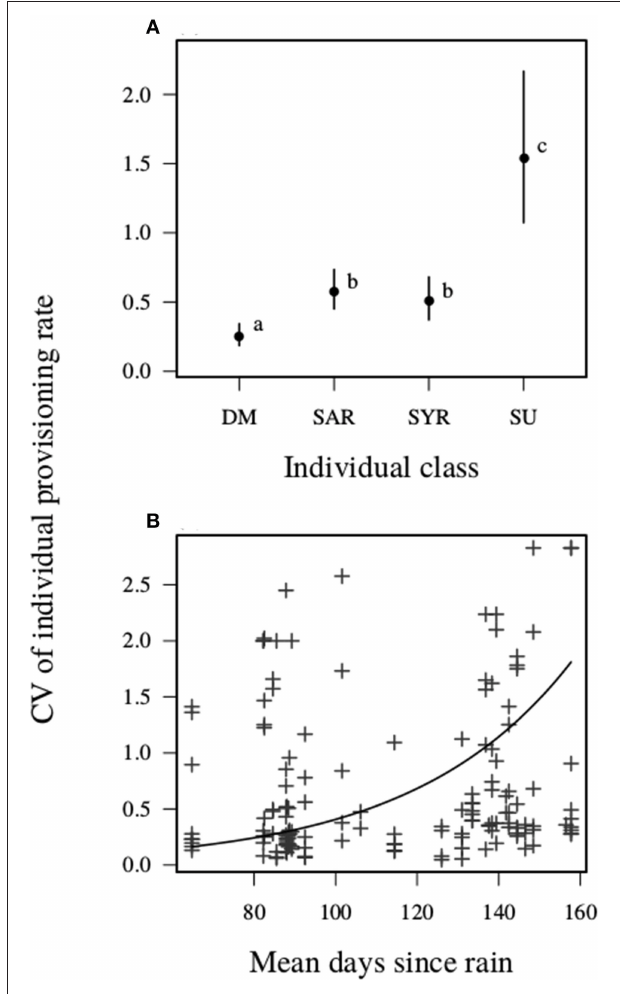
FIGURE 5 | Coefficient of variation (CV) in carer nest visitation among days. (A) The CV of individual provisioning rate differed among different classes of individuals, and (B) increased as a function of mean days since last meaningful rain. Acronyms as for Figure 2 , and letters inset indicate that 95% CI of the difference between the categories did not include zero. Plots show predicted means, and error bars show 95% CI.